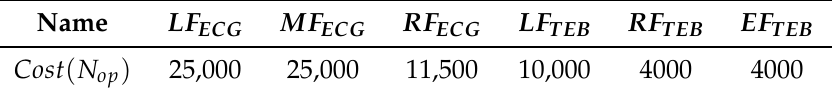
Table 2. Computational cost for each filter in the real-time